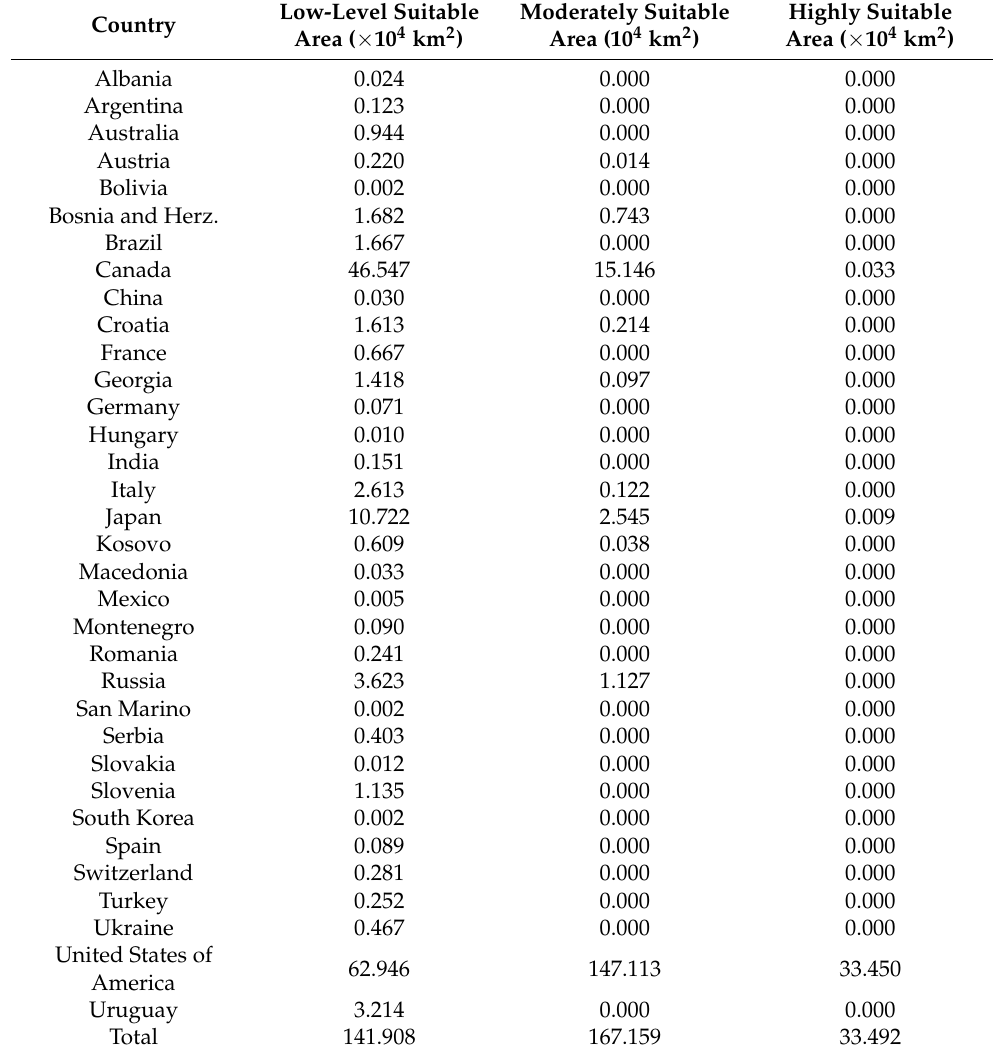
Table 3. Current distribution area of Liriodendron tulipifera .